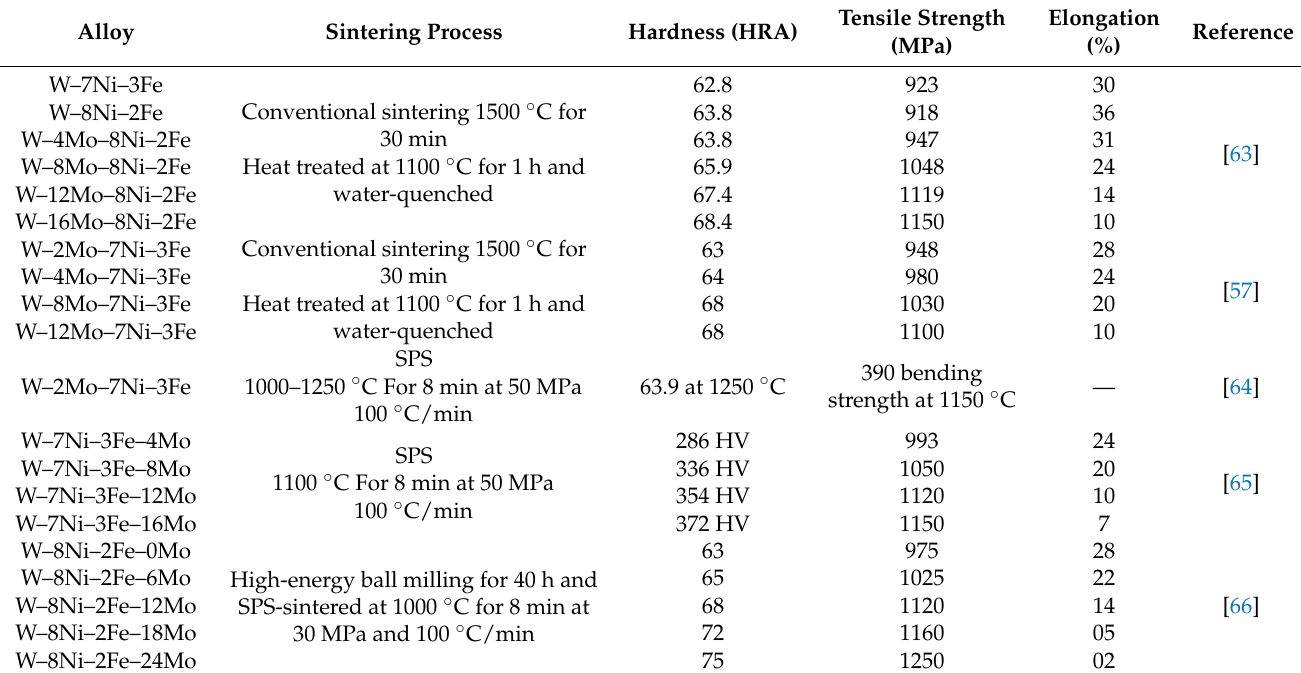
Table 3. Mechanical properties of tungsten heavy alloy of W–Ni–Fe with added